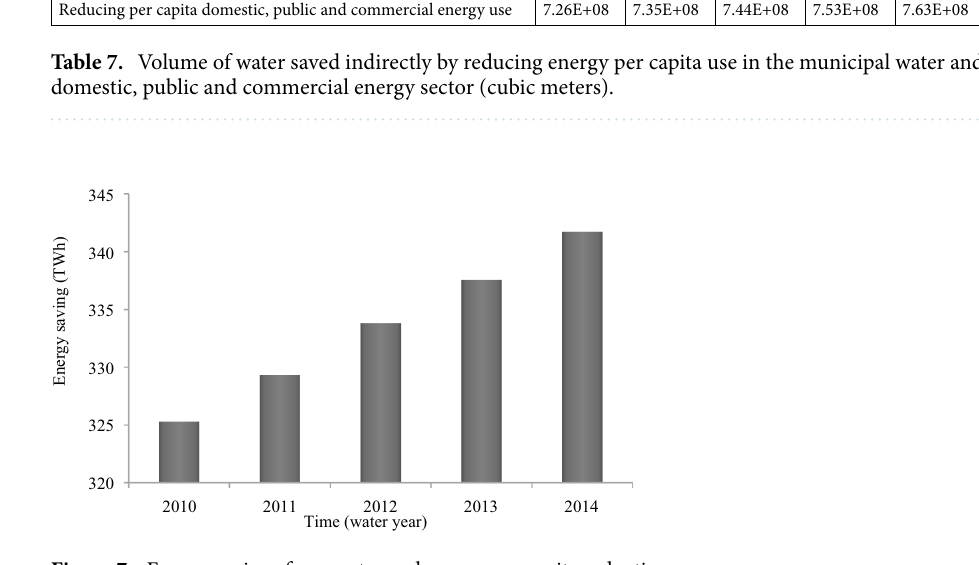
Figure 7. Energy savings from water and energy per capita